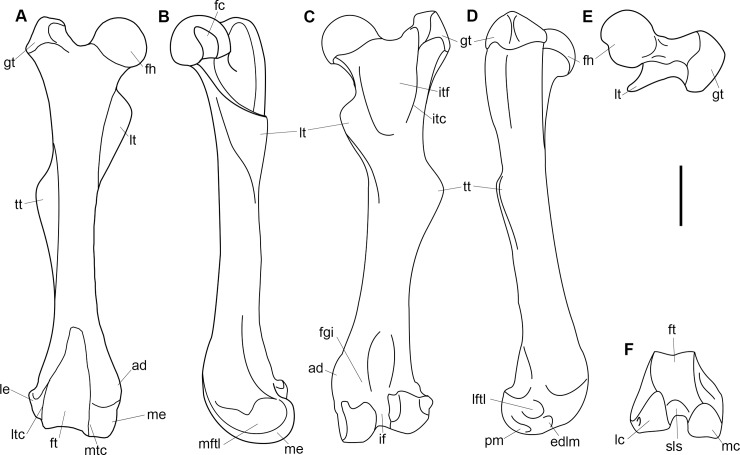
Annotated line drawing of the right femur of Periptychus carinidens.(A) anterior view; (B) medial view; (C) posterior view; (D) lateral view; (E) proximal view; (F) distal view. Abbreviations: edlm, fossa for the attachment of the extensor digitorum longus muscle; fc, fovea capitis; fgi, fossa for the gastrocnemius internus; fh, femoral head ft, femoral trochlea; gt, greater trochanter; lc lateral condyle; le, lateral epicondyle; if, intercondylar fossa; lftl, fossa for attachment of the lateral femorotibial ligament; lt, lesser trochanter; ltc, lateral trochlear crest; itc, intertrochanteric crest; itf, trochanteric fossa; mc, medial condyle; me, medial epicondyle; mftl, fossa for attachment of the medial femorotibial ligament; mtc, medial trochlear crest; pm, fossa for the attachment of the popliteus muscle, sls, semi-lunar surface; tt, third trochanter. Scale bars: 30mm.